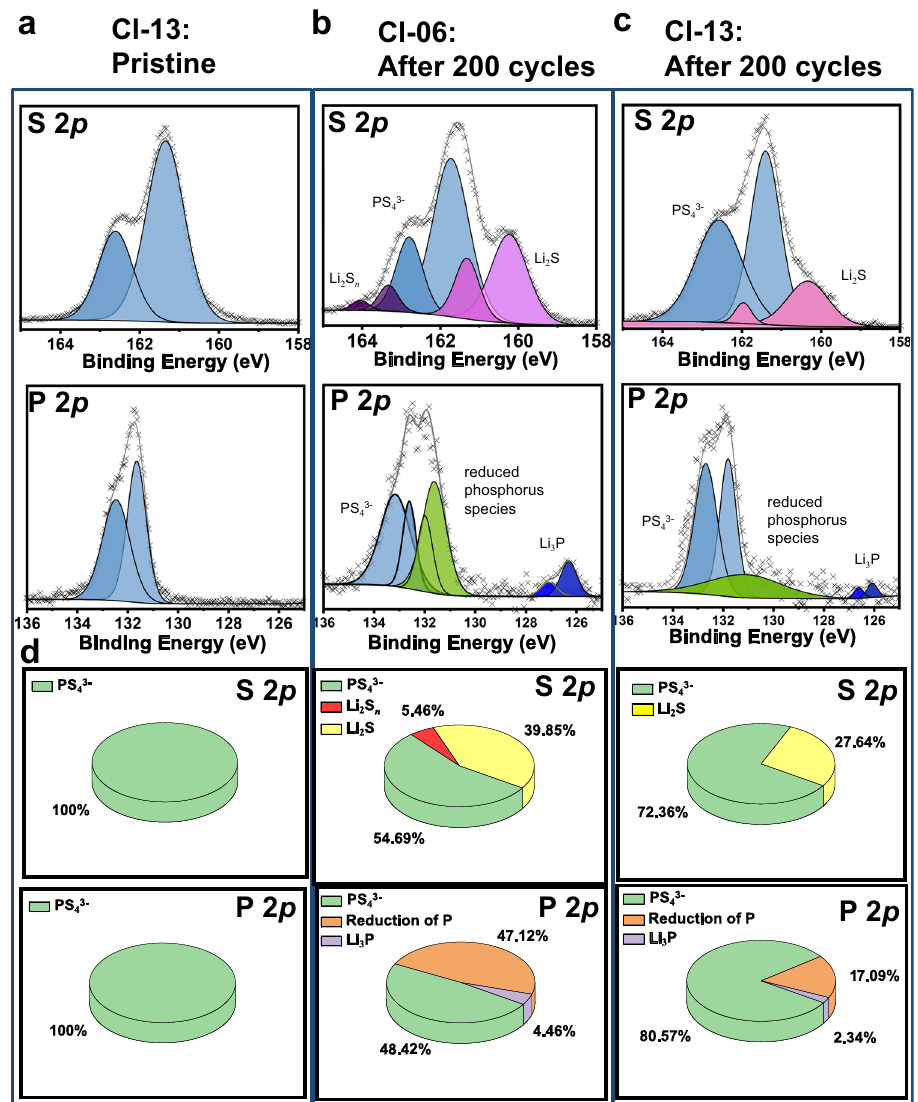
Fig. 8 XPS evaluation on Li|SE interface for Li||Li symmetric cells using Cl-06 and Cl-13 SEs after Li plating/stripping for 200 cycles. a Cl-13 before cycling. Cl-06 ( b ) and Cl-13 ( c ) after 200 cycles. d semi-quantitative analyses of the